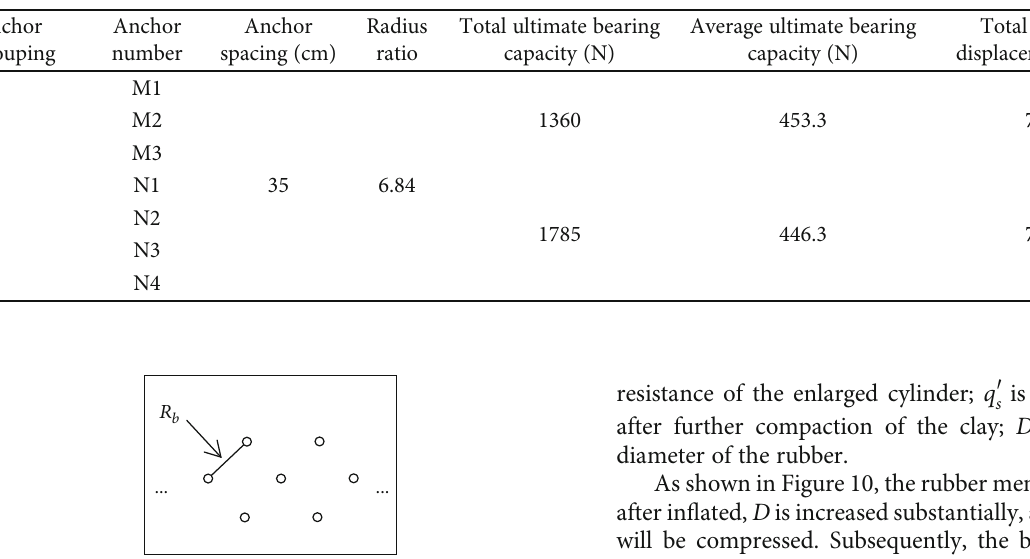
Table 5: Comparison test results of three and four anchors.